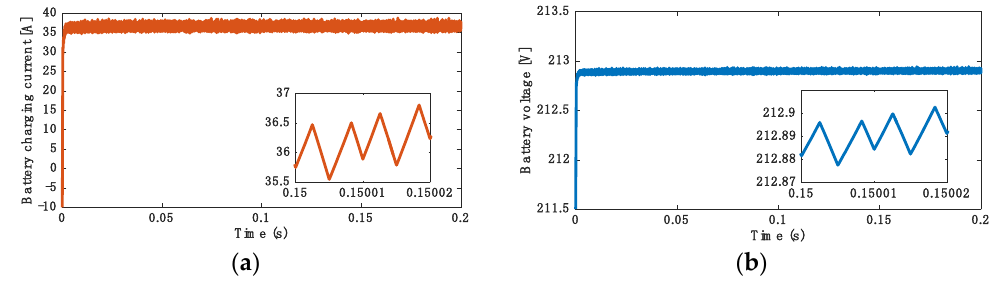
Figure 16. G2V: ( a ) Battery charging current; ( b ) Battery voltage.